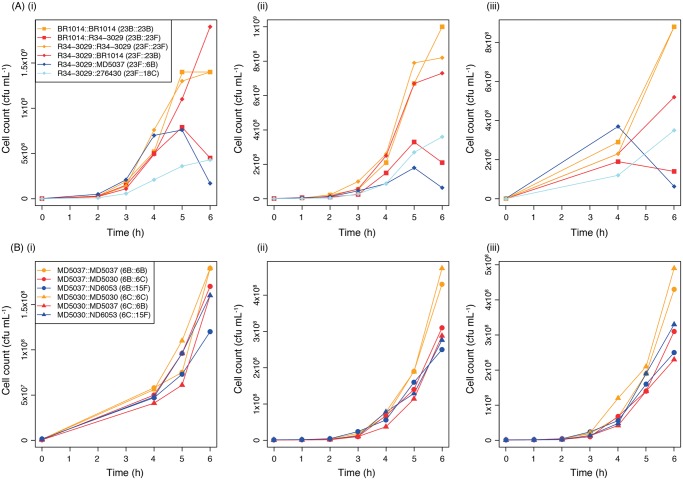
Growth curves comparing the fitness of genetic backgrounds expressing different serotypes.(A) Effect of capsule switching on the growth of two isolates from SC9. Three replicate experiments (i-iii) are shown in which six mutants were compared. Four were constructed based on isolate R34-3029 (diamond points): one in which the native 23F capsule was restored (orange); a within-serogroup switch to the 23B capsule (red); a between-serogroup switch to the 18C capsule (light blue); and a further between-serogroup switch to the 6B capsule (blue). Two other mutants were constructed based on isolate BR1014 (square points): one in which the native 23B capsule was restored (orange), and a within-serogroup switch to 23F (red). (B) Effect of capsule switching on the growth of two isolates from SC13. Three replicate experiments (i-iii) are shown in which six mutants were compared. Three mutants were based on isolate MD5037 (circular points): a restoration of the native 6B capsule (orange); a within-serogroup switch to the 6C capsule (red); and a between-serogroup switch to the 15F capsule (blue). The other three mutants were based on isolate MD5030 (triangular points): a restoration of the native 6C capsule (orange), a within-serogroup switch to the 6B capsule (red); and a between-serogroup switch to the 15F capsule (blue).